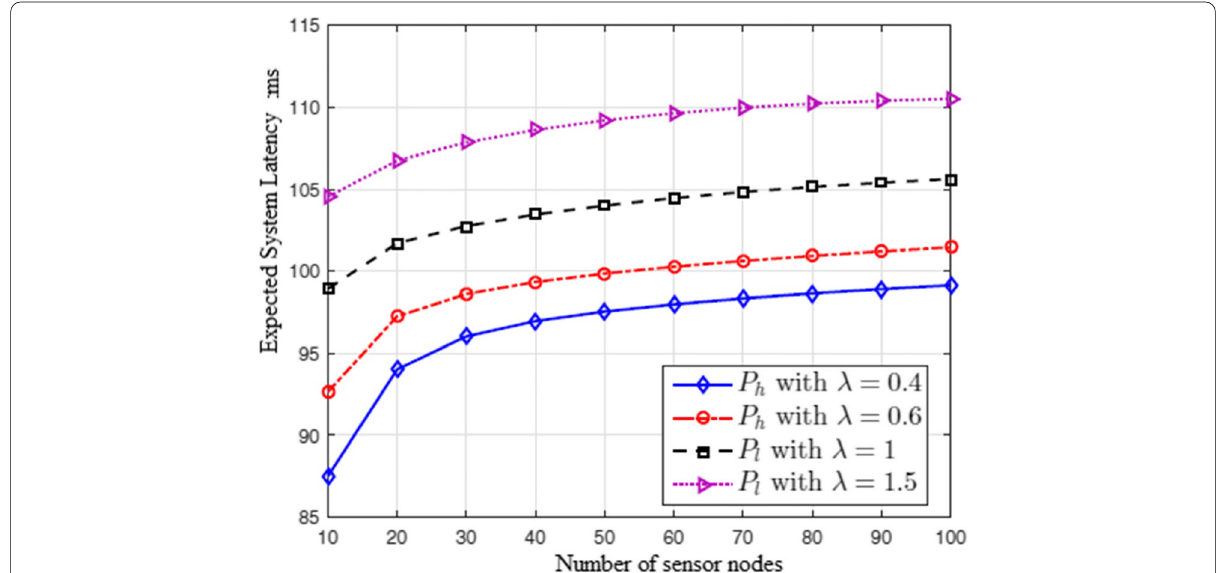
Fig. 5 Expected system